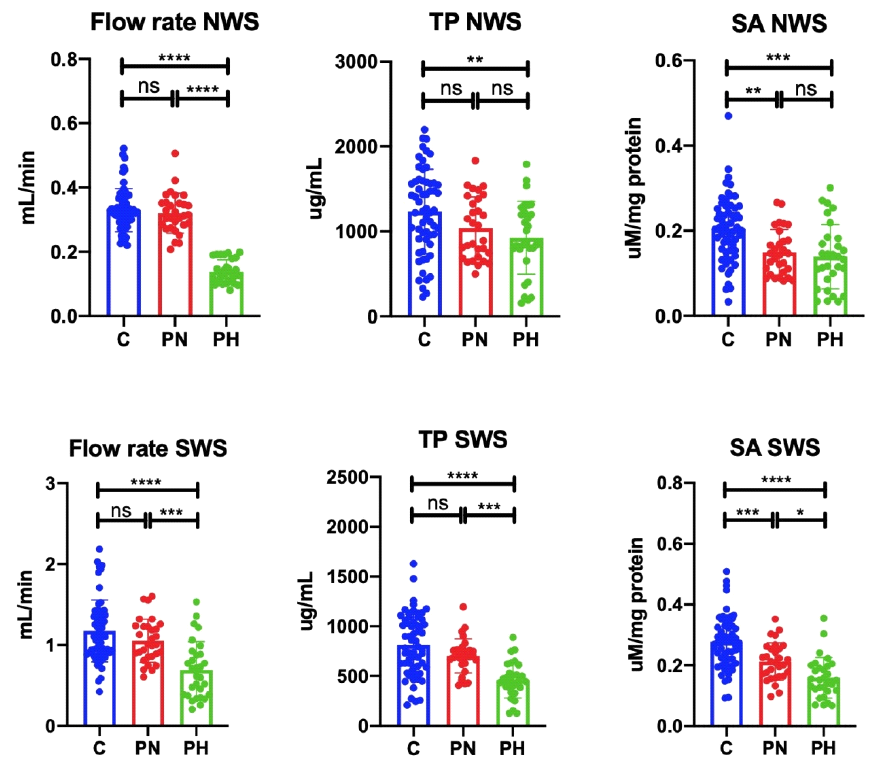
Figure 3. Salivary gland function in plaque psoriasis patients and control subjects. Abbreviations: C—the control; NWS—non-stimulated whole saliva; ns—not significant; PN—psoriasis patients